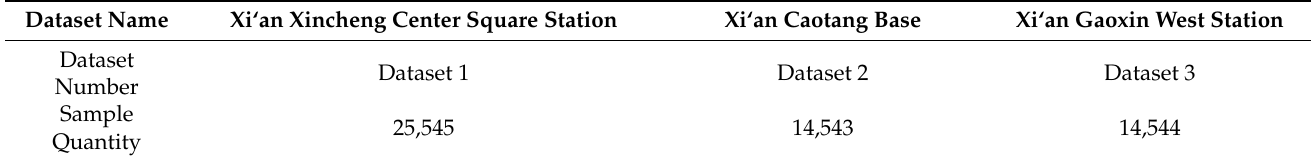
Table 5. The quantity of samples in the reconstructed datasets.